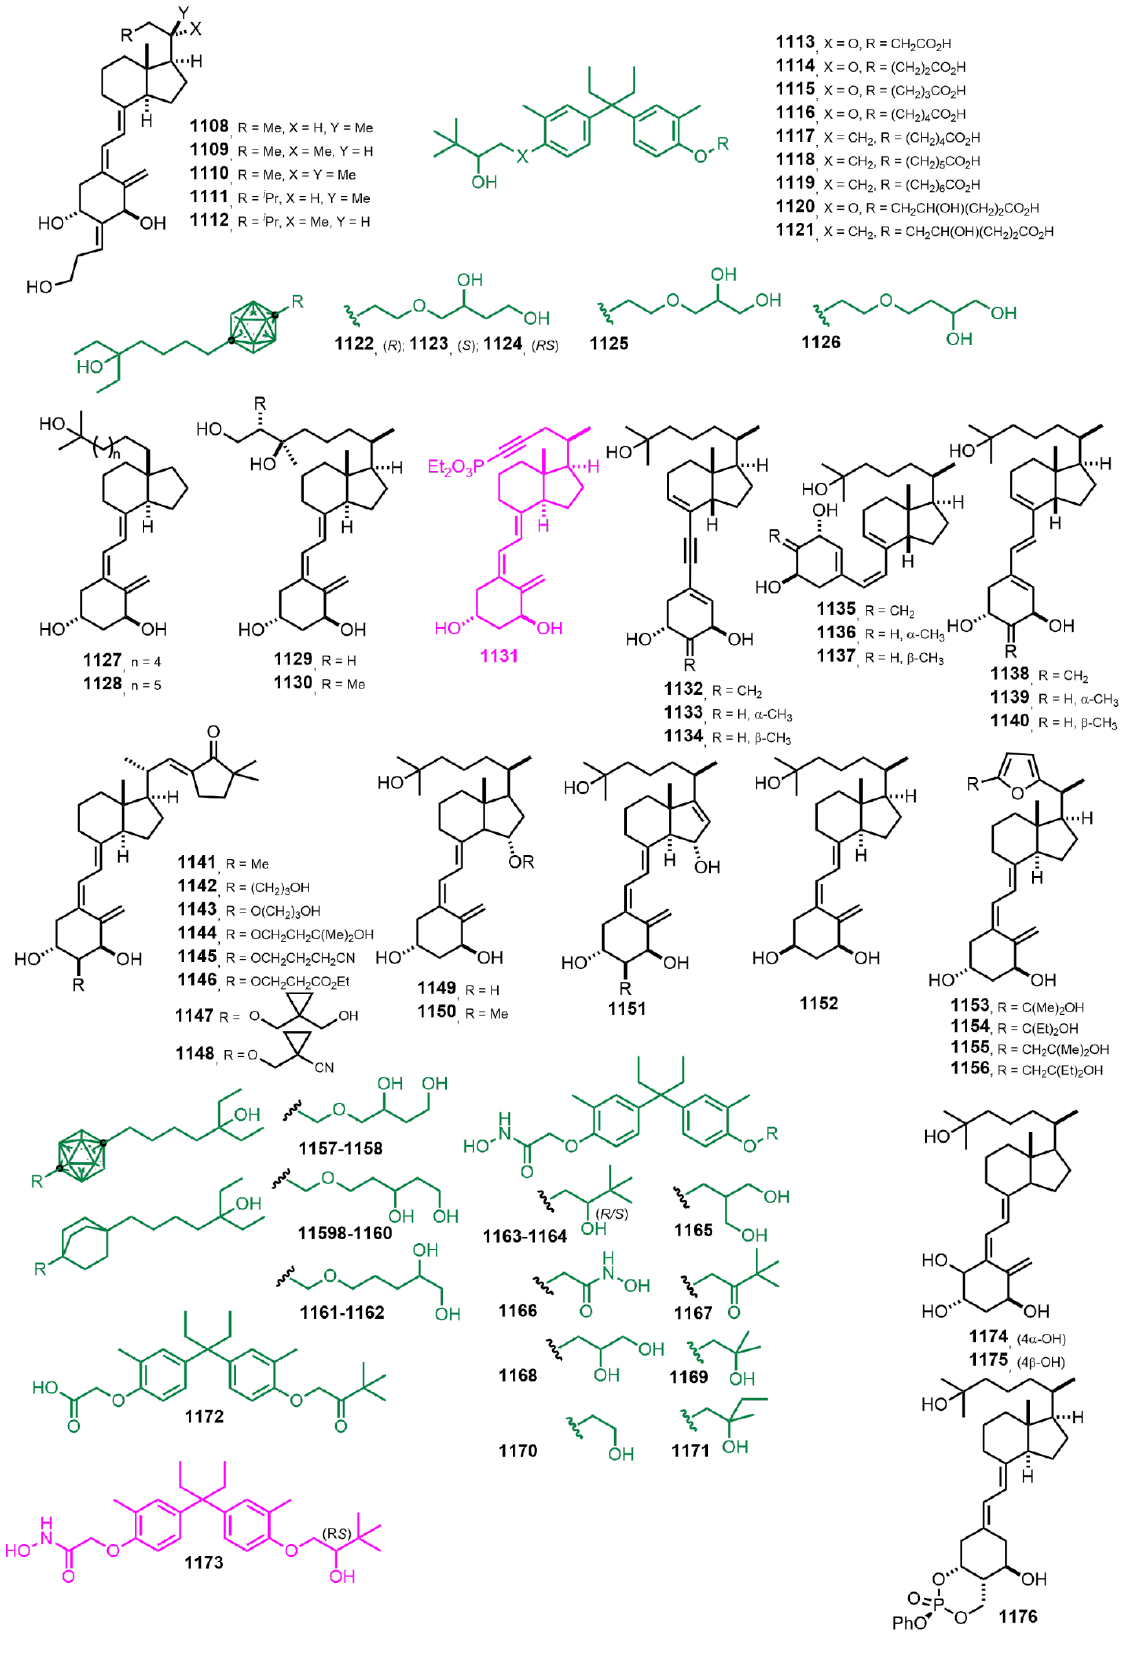
Figure 20. (2010–2012)